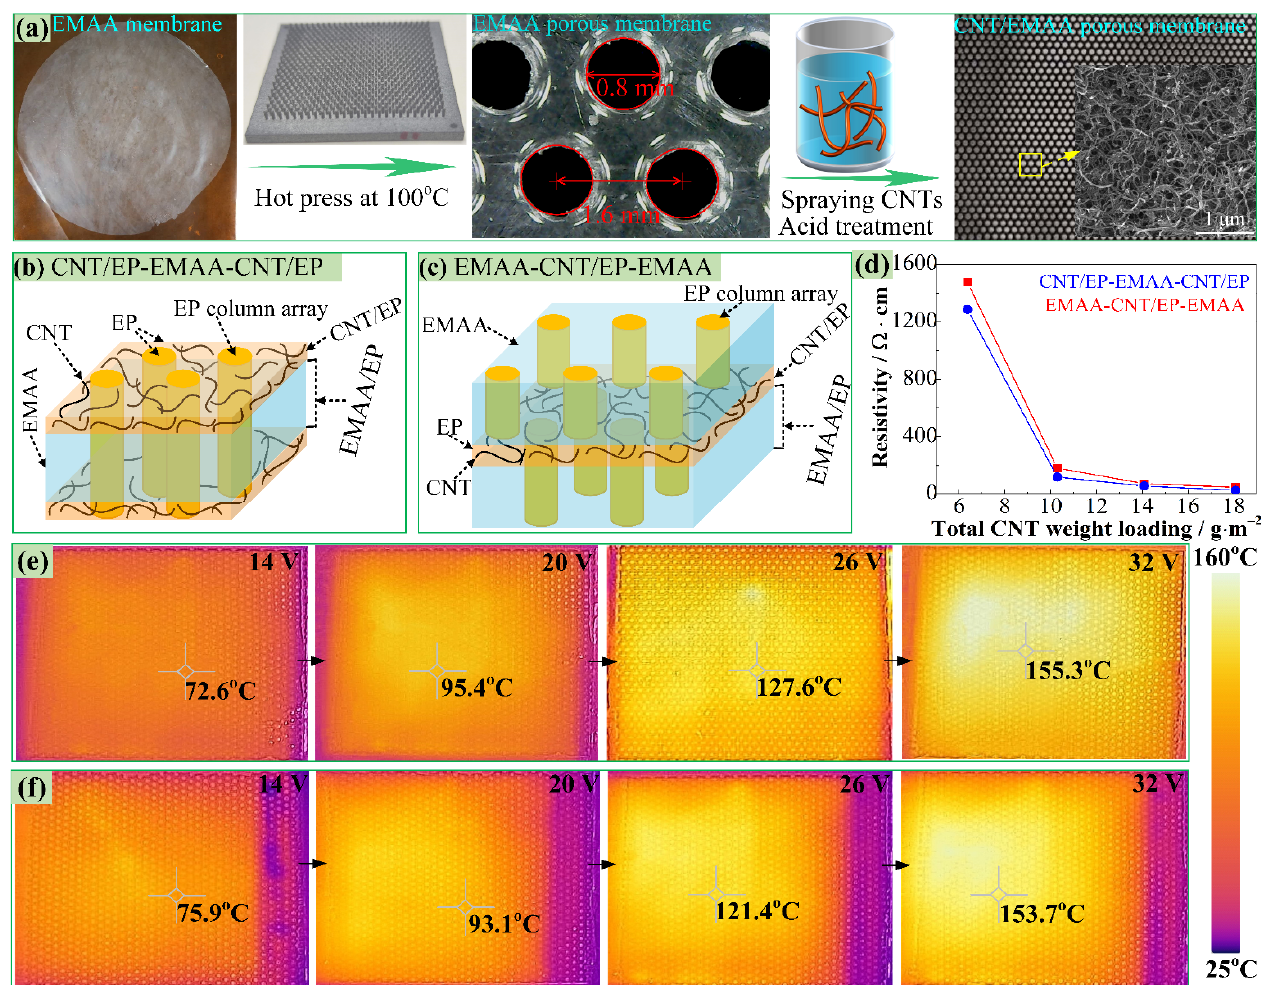
Figure 1. ( a ) Fabrication of CNT/EMAA porous membrane, ( b , c ) schematic diagrams of CNT/EP ‐ EMAA ‐ CNT/EP and EMAA ‐ CNT/EP ‐ EMAA interleaves, ( d ) resistivity of the interleaves versus the total CNT weight loadings, ( e , f ) infrared temperature fields of CNT/EP ‐ EMAA ‐ CNT/EP and EMAA ‐ CNT/EP ‐ EMAA at different input voltages. Then, the CNT/EP ‐ EMAA ‐ CNT/EP and EMAA ‐ CNT/EP ‐ EMAA interleaves were re ‐